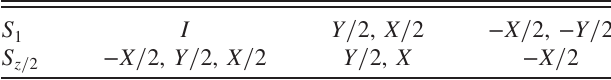
TABLE V. The three-element single-qubit rotation groups S 1 and S written in terms of X - and Y -rotation gates in time. z= 2